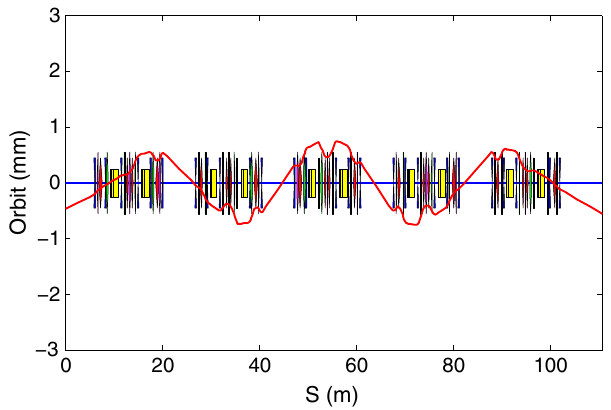
FIG. 1. Sketch of the two spatially separated bunch trains in the SSRF storage ring. (A quarter of the full ring lattice is shown here. The blue line is the golden orbit and the red one is the distorted orbit that is kicked by 100 μ rad in the vertical plane by a fast kicker located at the end of the second straight